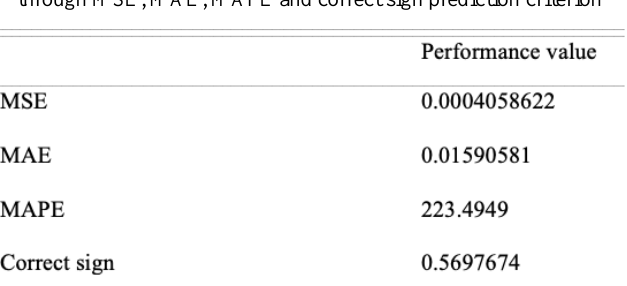
Table 10: Forecasting performance of rolling window forecasting